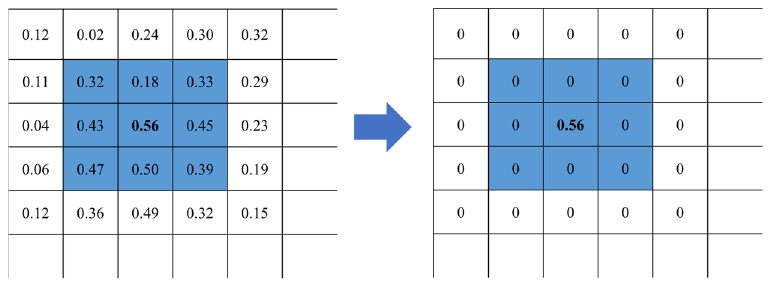
Figure 6. The local maximum value is retained, and other positions are assigned to 0.